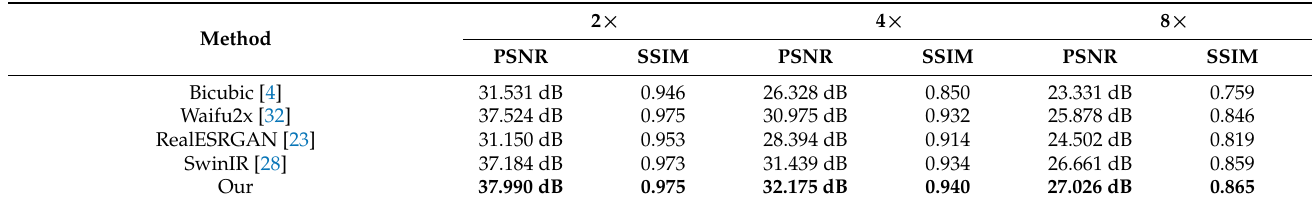
Table 5. Comparison with other super-resolution methods on the Multi-level anime83 test dataset (83 images). The final result is the average result of 83 test images in the Multi-level anime83 test dataset (best results are indicated with bold). N =